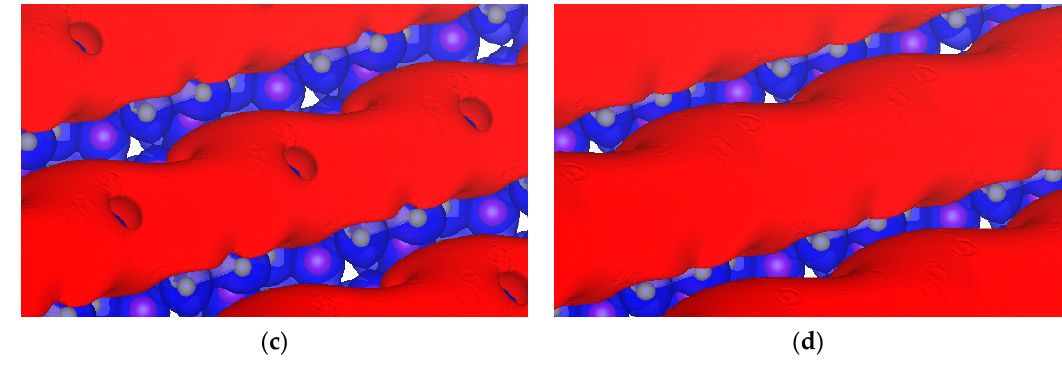
Figure 12. Isopotential surfaces of Li 7 P 2 S 8 I, separated between negative (red) and positive (blue) regions. Positive isopotential remains constant at +0.5 V, and negative isopotentials are ( a ) − 3.8; ( b ) − 3.6; ( c ) − 3.5; and ( d ) − 3.4 V.